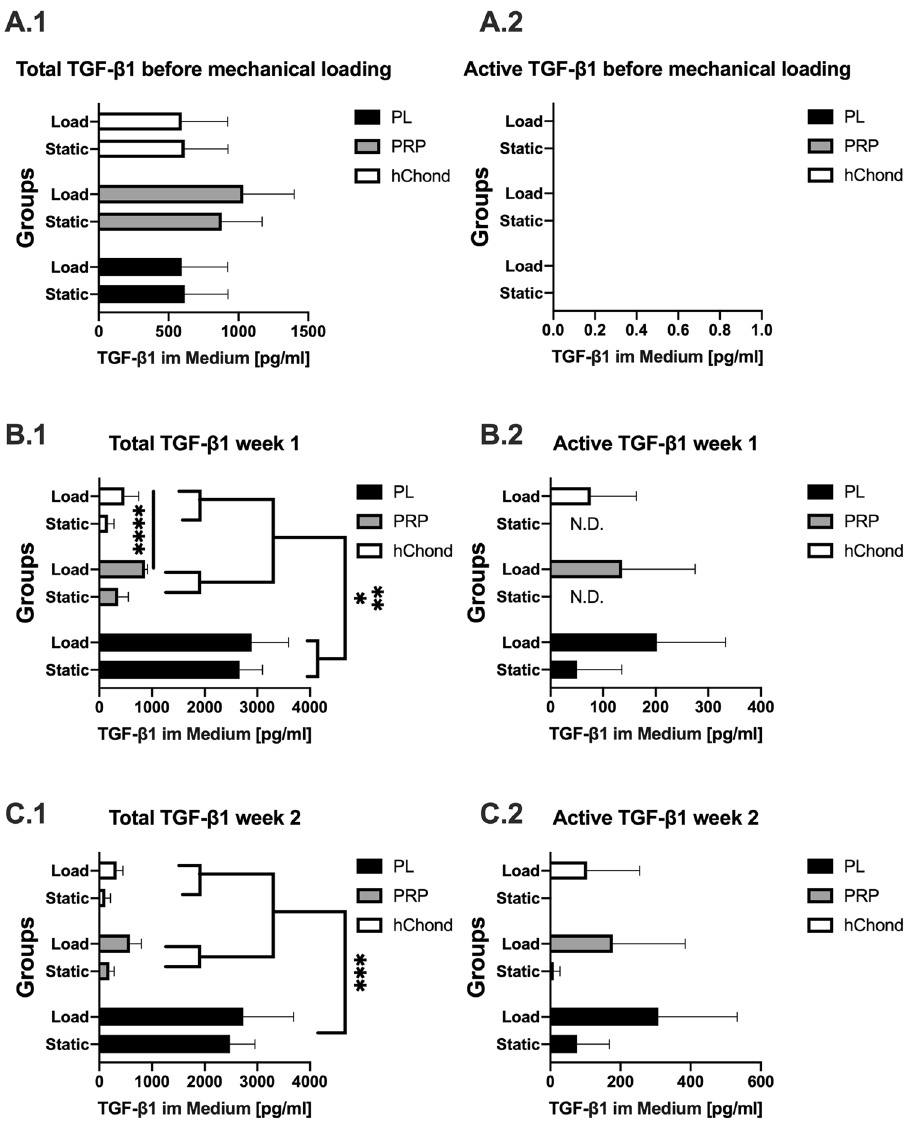
Figure 7. Total and activated TGF-β1 in cell culture medium, structured in time by ( A ) preculture before mechanical loading, ( B ) week 1 and ( C ) week 2. Data is shown as mean ± SD, statistical significance was defined as * p < 0.05, ** p < 0.01, *** p < 0.001, **** p <